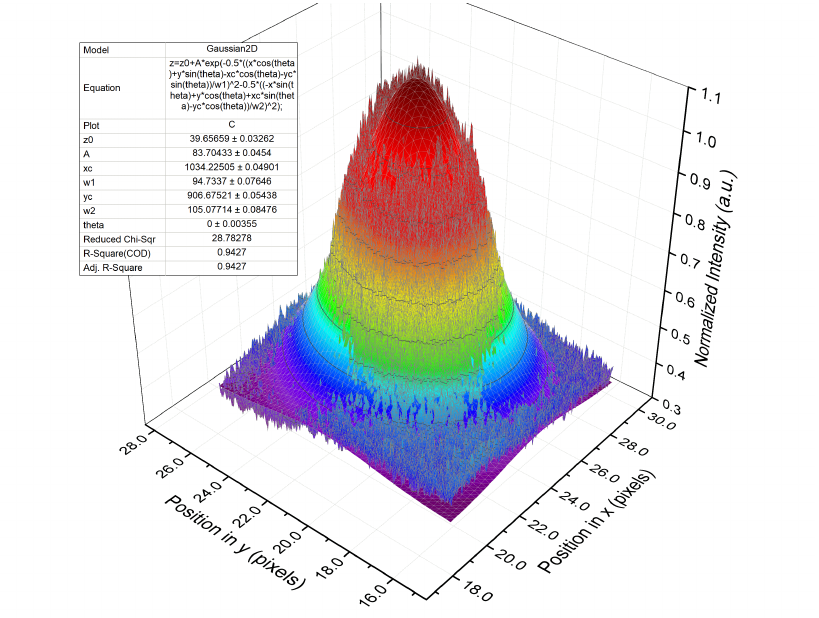
Figure 8. Image intensity profile measured from the image generated on the P43 screen for very low energy proton beam, and the Gaussian that fits it.